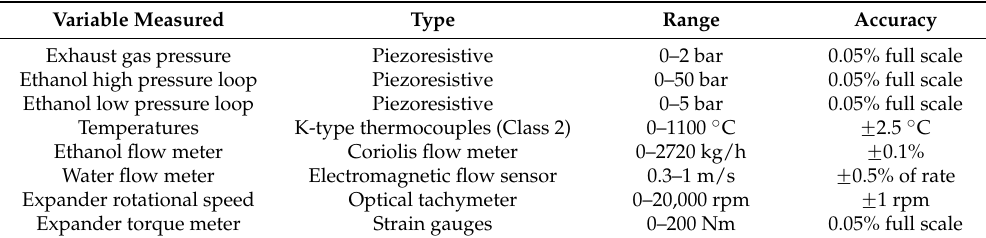
Table 2. Range and accuracy of sensors.